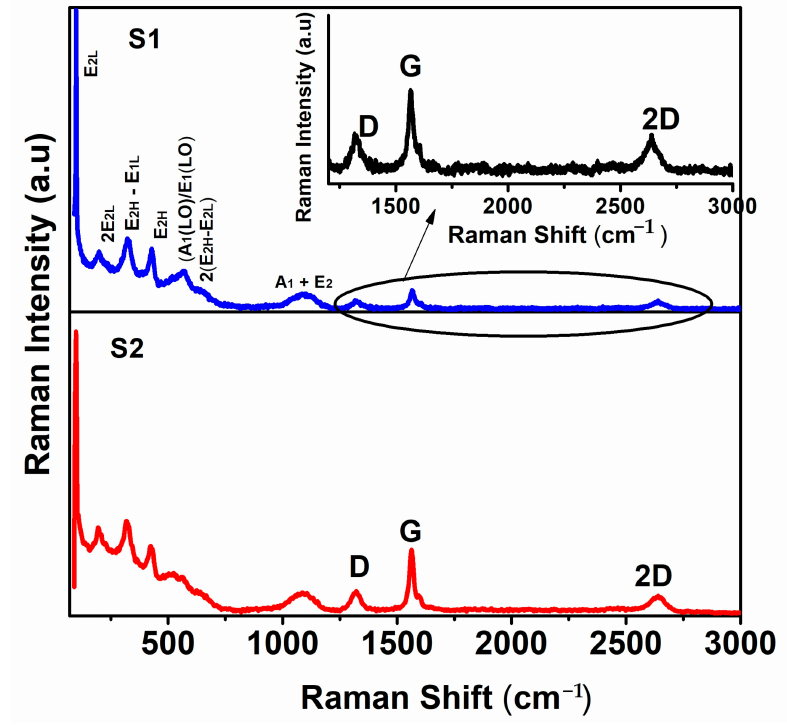
Figure 2. Micro Raman spectra of ZnO/graphene